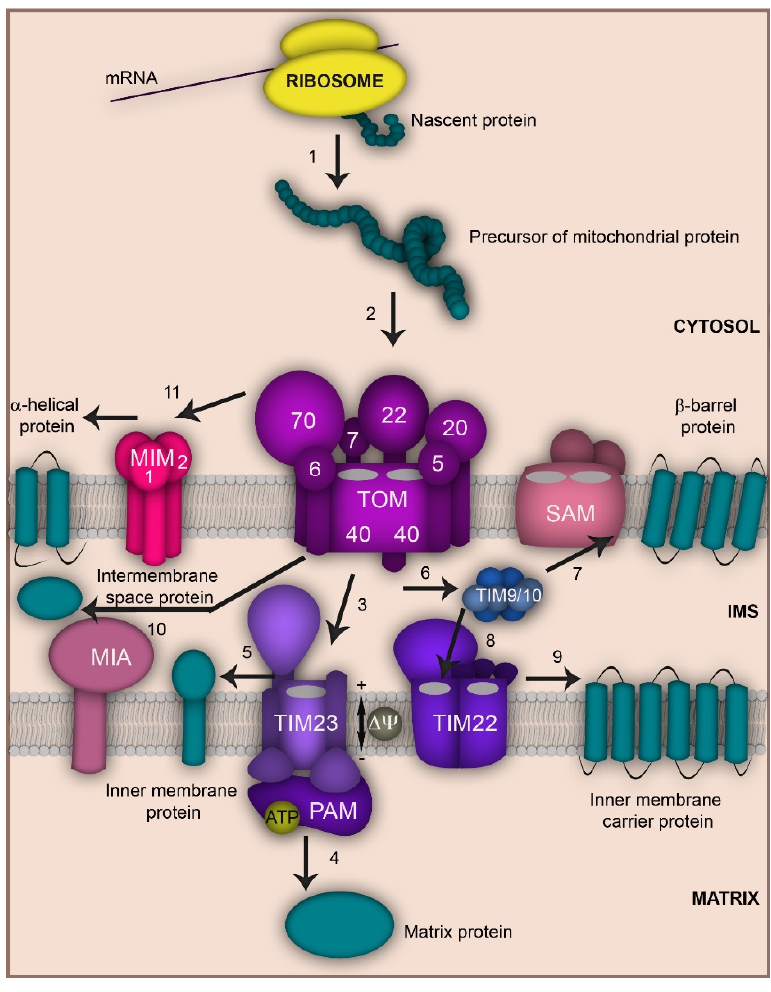
FIGURE 1: Overview of the main mito- chondrial protein import pathways.